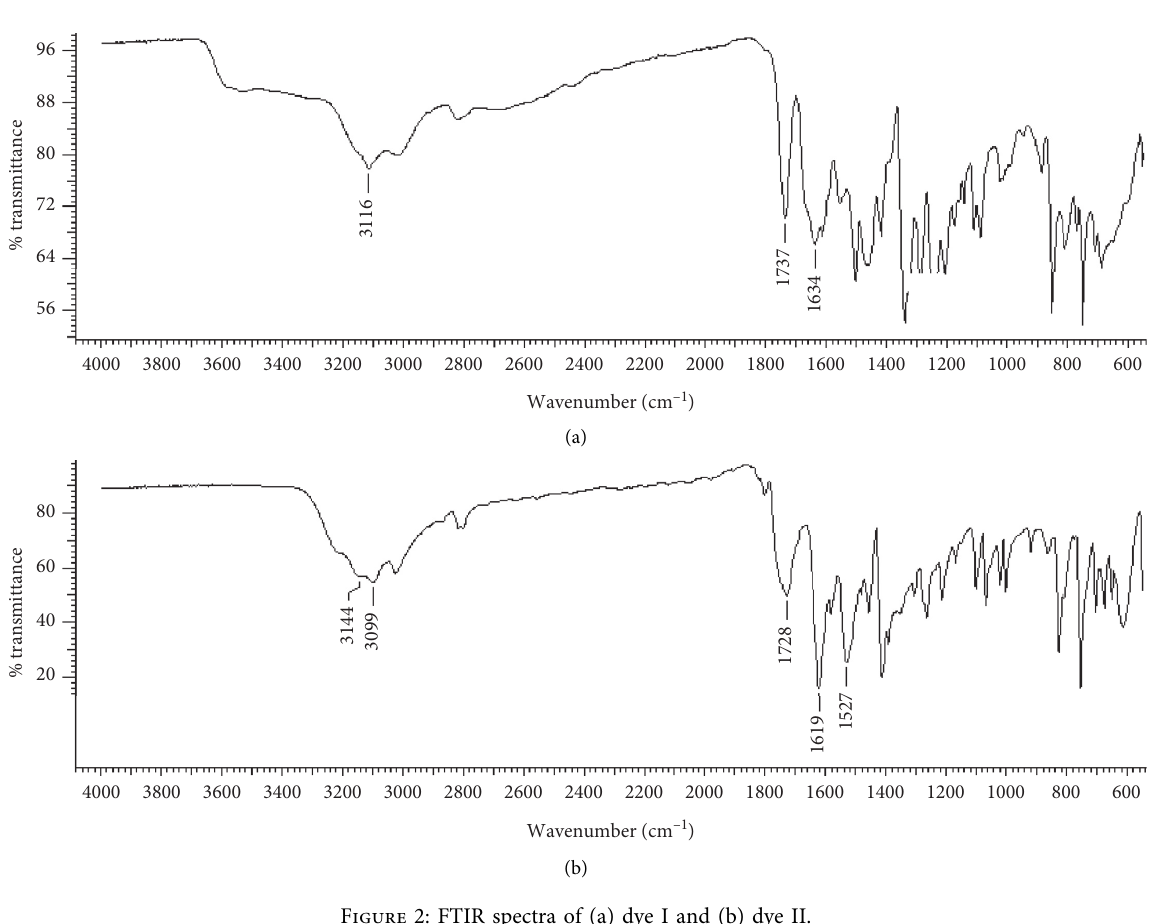
Figure 2: FTIR spectra of (a) dye I and (b) dye